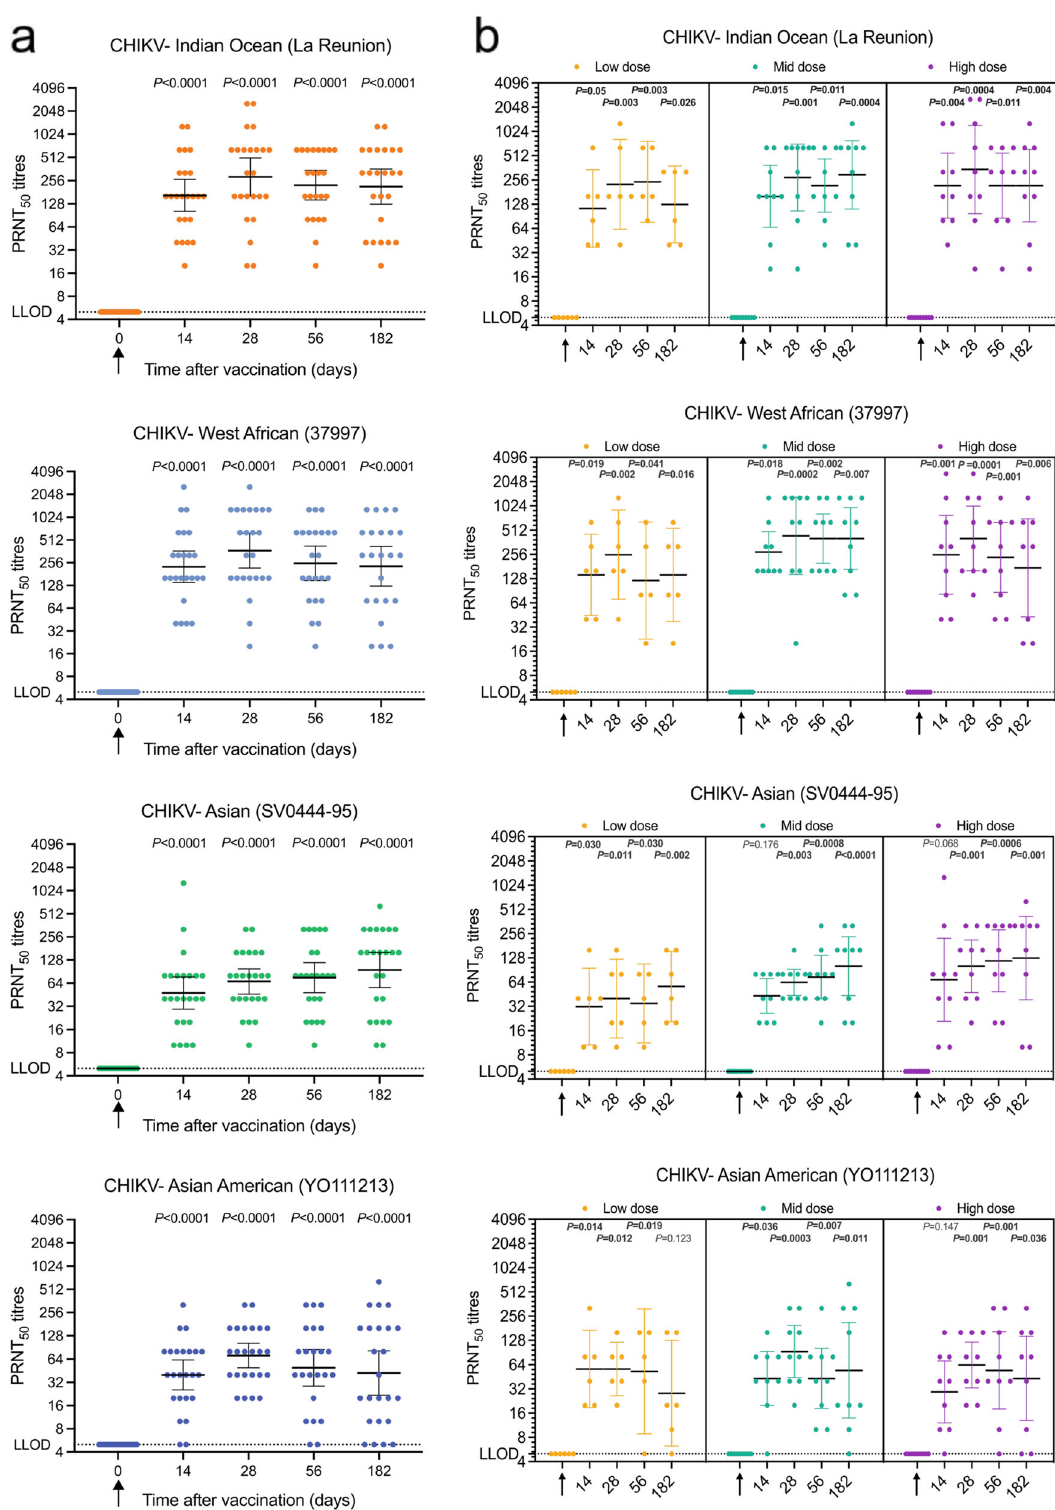
Fig. 2 PRNT 50 values over time. PRNT 50 reciprocal titers are shown for each participant. Arrows indicate when ChAdOx1 Chik was administered. Lower limit of detection (LLOD) is 5. a Overall responses by timepoint in all trial volunteers ( n = 24). Geometric means and 95% CI; Kruskal – Wallis test with Dunn ’ s correction. b Same data as ( a ) but analyzed by dosage groups: low dose was 5 × 10 9 vp ( n = 6), intermediate (mid) dose was 2.5 × 10 10 vp ( n = 9), and high dose was 5 × 10 10 vp ( n = 9). Geometric means and 95% CI; Kruskal – Wallis test with Dunn ’ s correction. One day 56, the sample from the low- dose group was excluded from analysis due to QC